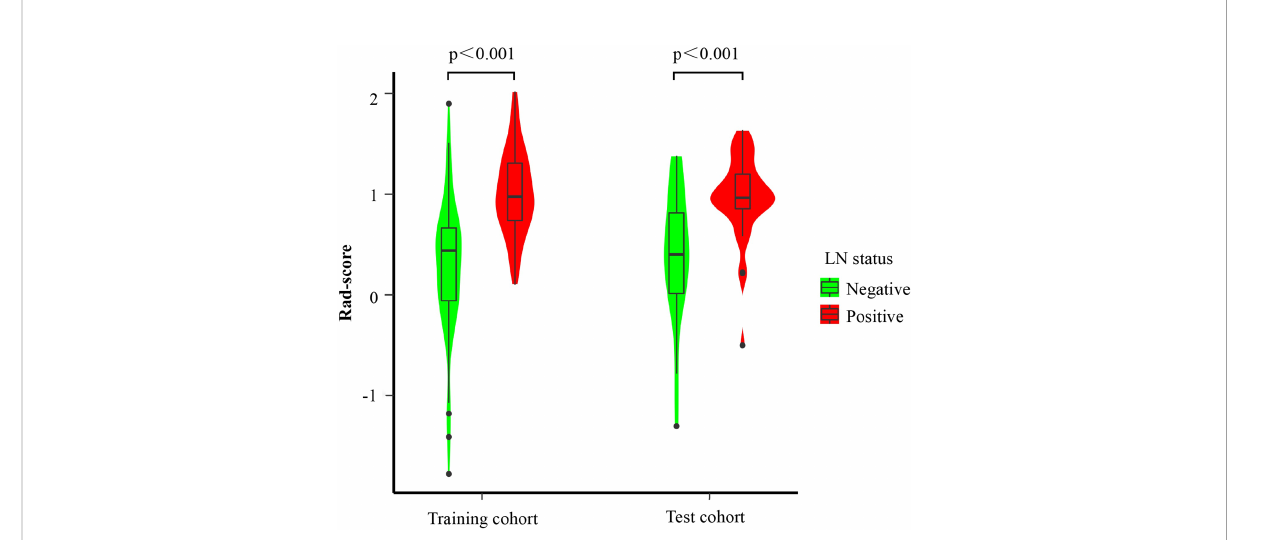
FIGURE 3 Boxplots of the Radiomics score (Rad-score) for the training and validation